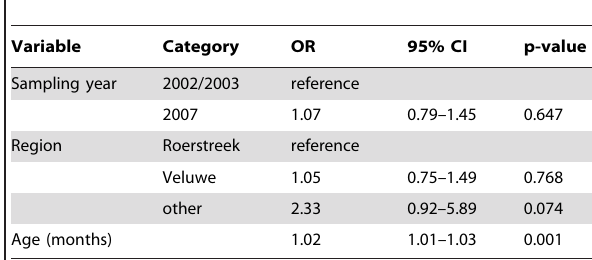
(Table 3). The model fitted the data (Hosmer and Lemeshow test [13], p = 0.068).